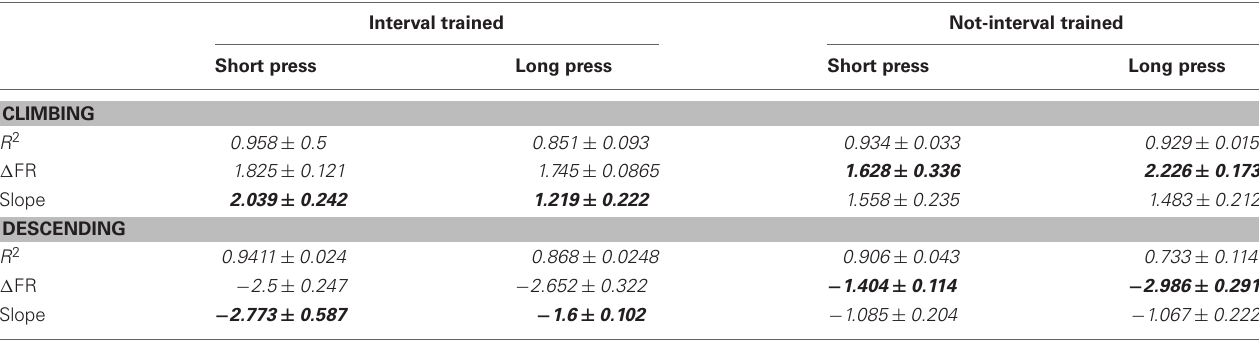
Table 3 | Comparison of climbing activity between short and long press for interval trained and non-interval trained animals. Interval trained Not-interval trained Short press Long press Short press Long